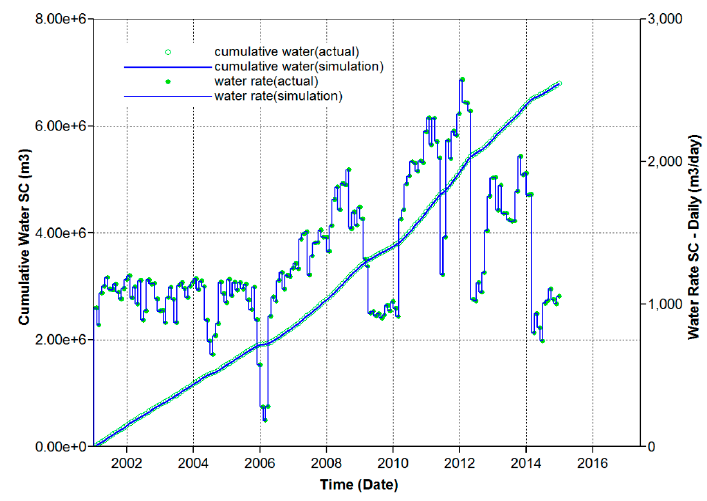
Figure 4. Fitting curve of the water injection rate in the experimental area.